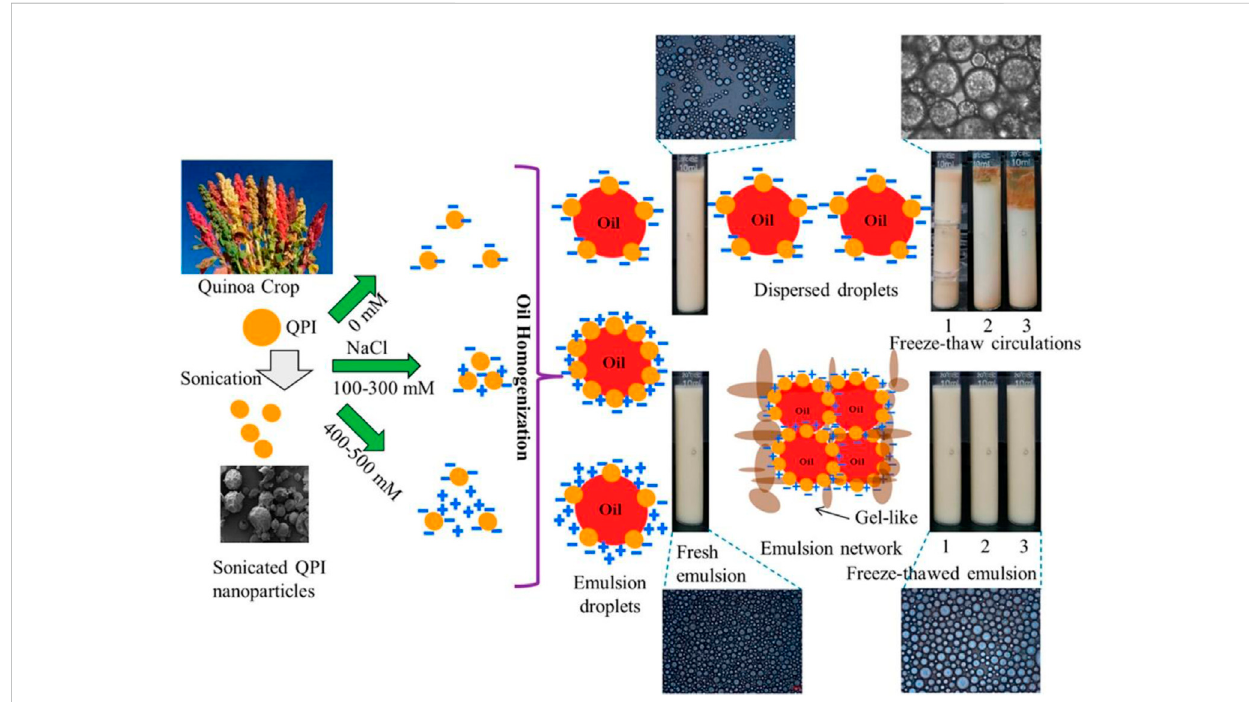
FIGURE 5 Schematic representation of the role of salt addition on the stabilization of pickering emulsions using quinoa protein particles. Reprinted from Qin et al. (2018), with permission from the American chemical society, copyright (2018).